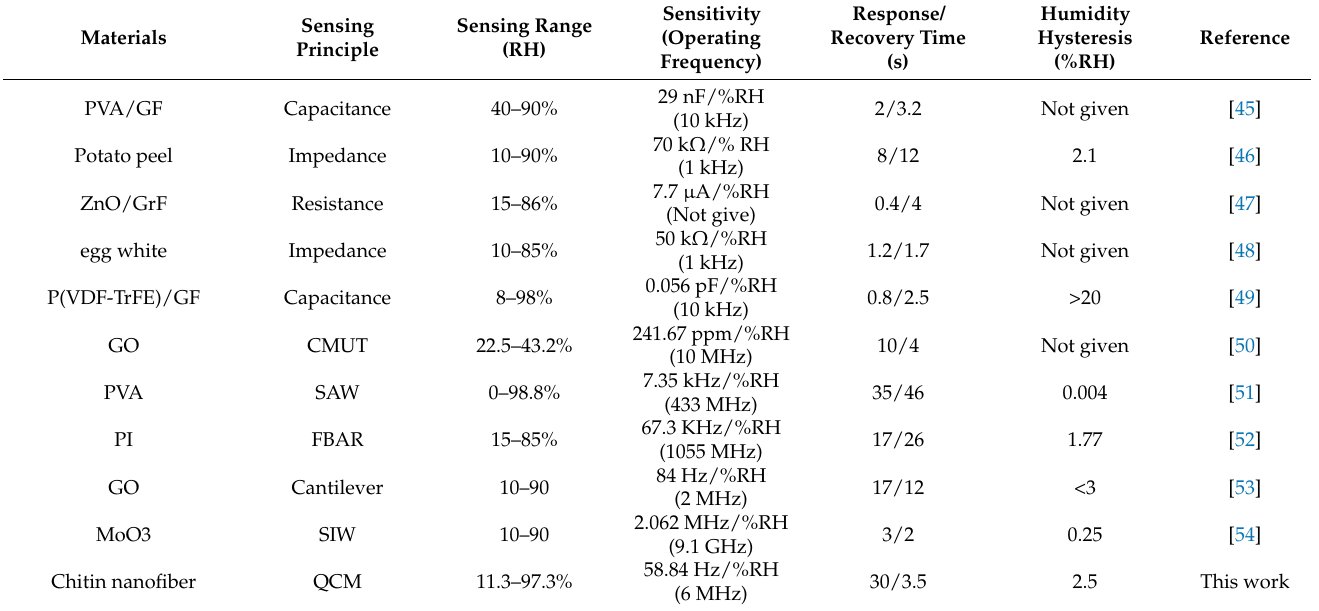
Table 4. Comparison of humidity sensing performance between ChNF-integrated n-m electrode QCM sensors and other types of humidity